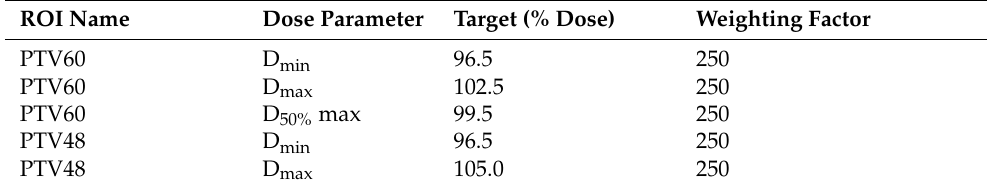
Table 2. Priority 2—Target Goals. Target represents percentage of PTV prescription